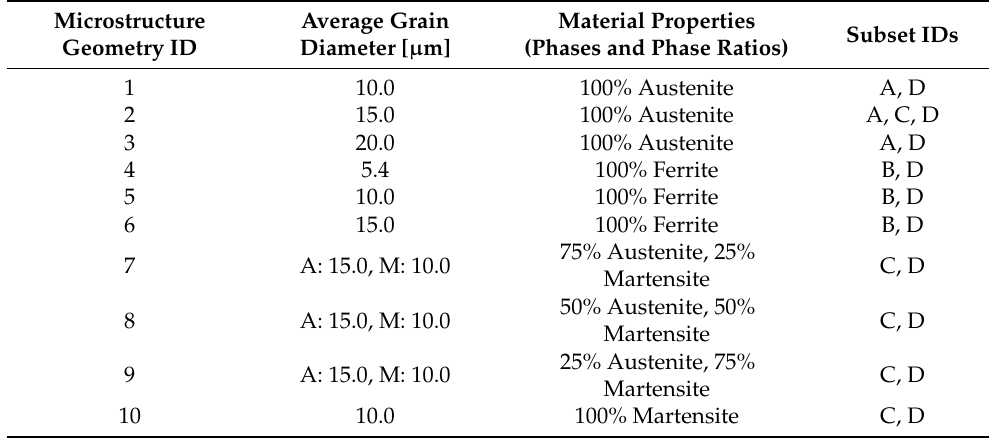
Table 2. Ten simulation cases for LUS simulations. Each case has been simulated at temperatures of 27 ◦ C, 300 ◦ C, 550 ◦ C, and 900 ◦ C. The subset IDs refer to the four cases in Section 3.